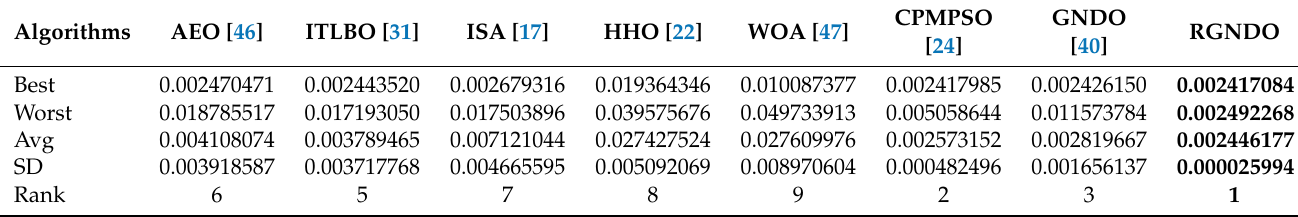
Table 10. Comparison of the fitness on Ultra 85-P.